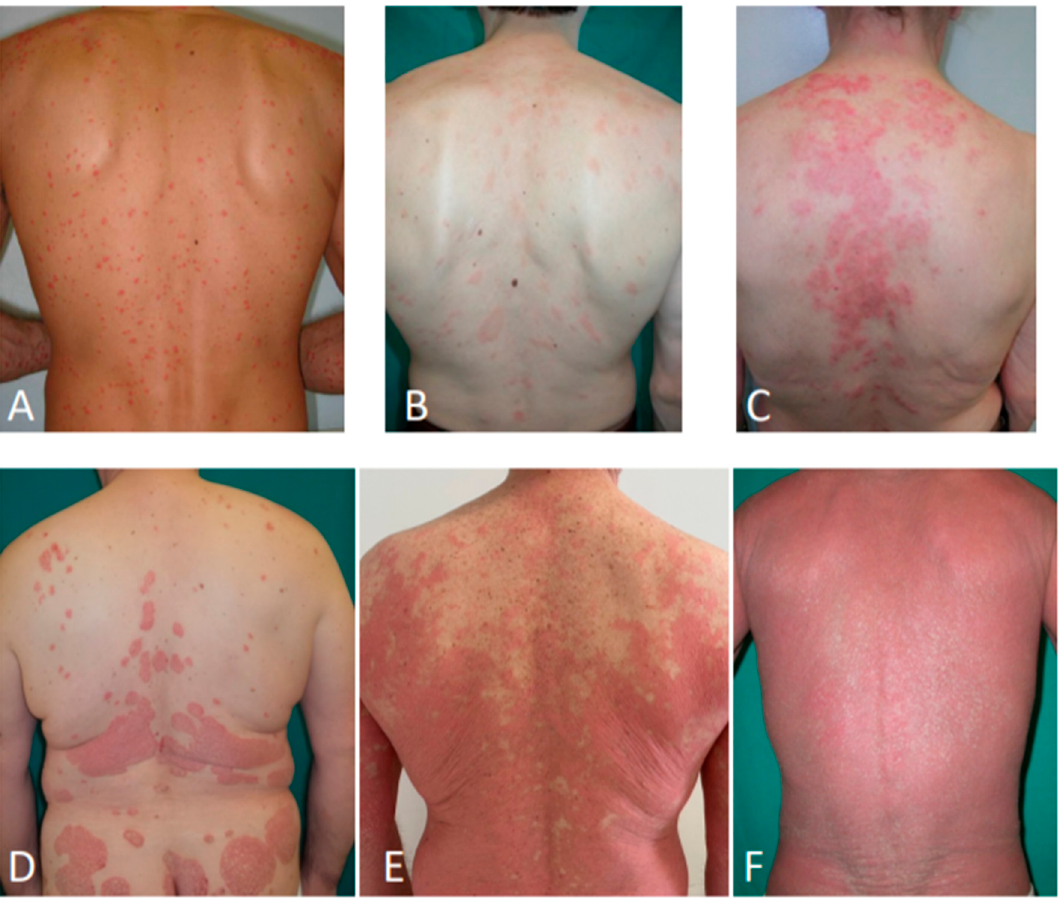
Figure 3. Secondary syphilis ( A ); pityriasis rosea ( B ); subacute cutaneous lupus erythematosus ( C ); psoriasis ( D ); pityriasis rubra pilaris ( E ); erythrodermic mycosis fungoides ( F ).